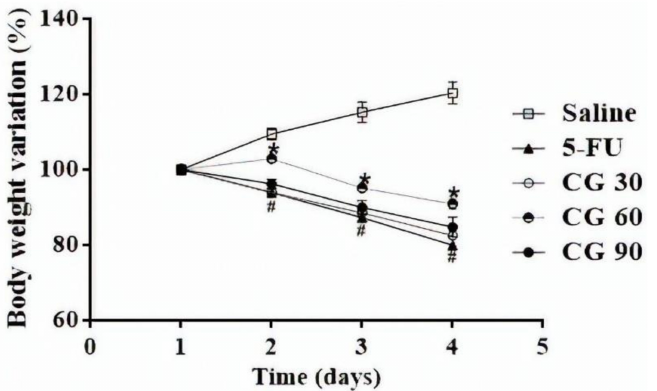
Figure 1. Body weight variation in mice subjected to intestinal mucositis (5-FU, 450 mg / kg, ip, single dose) and treated with CG (30, 60 and 90 mg / kg for 4 days). The results are expressed as the mean ± SEM of the weight evaluation percentage of the initial weight, of a minimum of 6 animals per